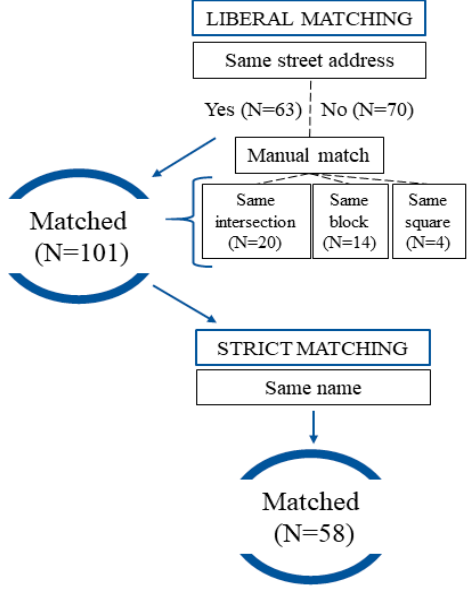
Figure 2. Flowchart illustrating data matching process using both (1) a liberal matching strategy (only by location); and (2) a strict matching strategy (both by location and outlet name).